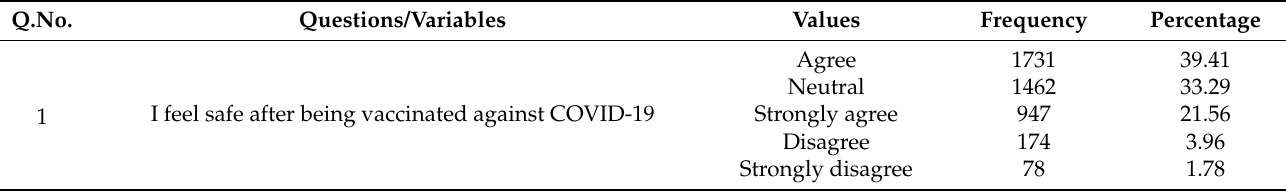
Table 4. The intentions toward COVID-19 vaccines among General Populations ( n =